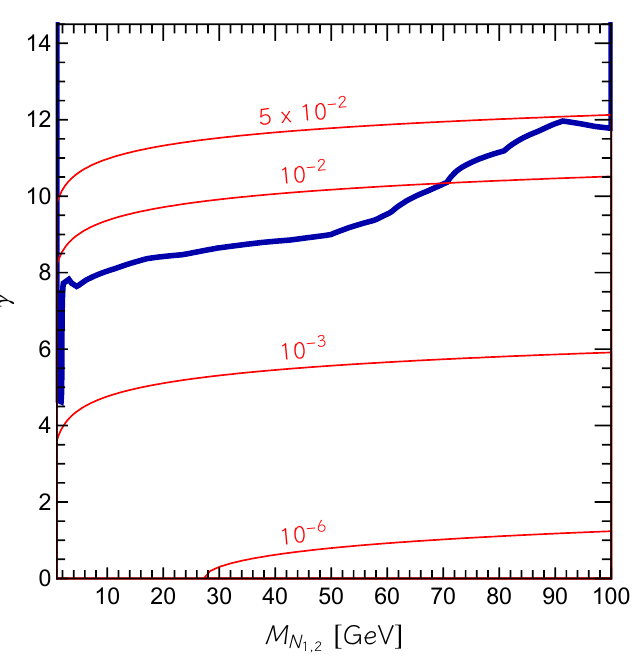
Figure 1 . Constraints on the mixing angles (cid:18) i = P j (cid:18) i;(cid:11) j 2 in the M N (cid:0) (cid:13) plane, where the (cid:11) =1 ; 2 masses of the RH neutrinos are taken degenerate with a value M N . The region above the colored 1 ; 2 thick line is excluded by the bounds on active-sterile mixing angles [46{48]. We show only the most restrictive bound for NH hierarchy, i.e. the one coming from the (cid:18) (cid:22) . The red thin lines show the corresponding maximum value of the active-sterile mixing angle computed according to eq.